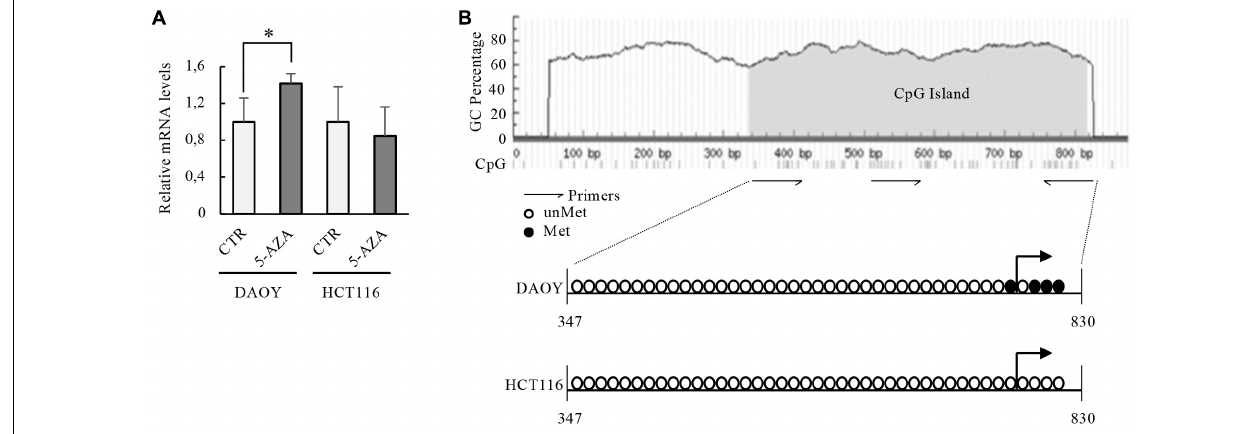
FIGURE 7 | Transcriptional activity of KCASH2 promoter in p53 mutated and WT tumor cell lines. (A) p53 mutant DAOY and p53 WT HCT116 cells were treated with 5-AZA (5 µ M). Then, KCASH2 mRNA levels were analyzed by RT-qPCR, normalized to Actin, and represented as fold induction on CTR. Bars represent the mean of three independent experiments ± SD. ∗ p < 0.05. (B) Methylation level of the CpG island on the KCASH2 proximal promoter. Genomic DNA was purified from DAOY and HCT116 cells and frequencies of CpG islands with and without methylation were measured by sequencing after bisulfate treatment. Methylation statuses of CpG dinucleotides are marked as non-methylated (open circle) and methylated (closed circle). Among marked regions, the methylation level was measured as a ratio of methylated CpG to total CpG. DAOY cells resulted methylated (10% CpGs), instead, HCT116 cells resulted totally unmethylated. The gray area on the schematic representation of the CpGs island indicate the CpG island, the dashes at the bottom of the sequence represent single CpG